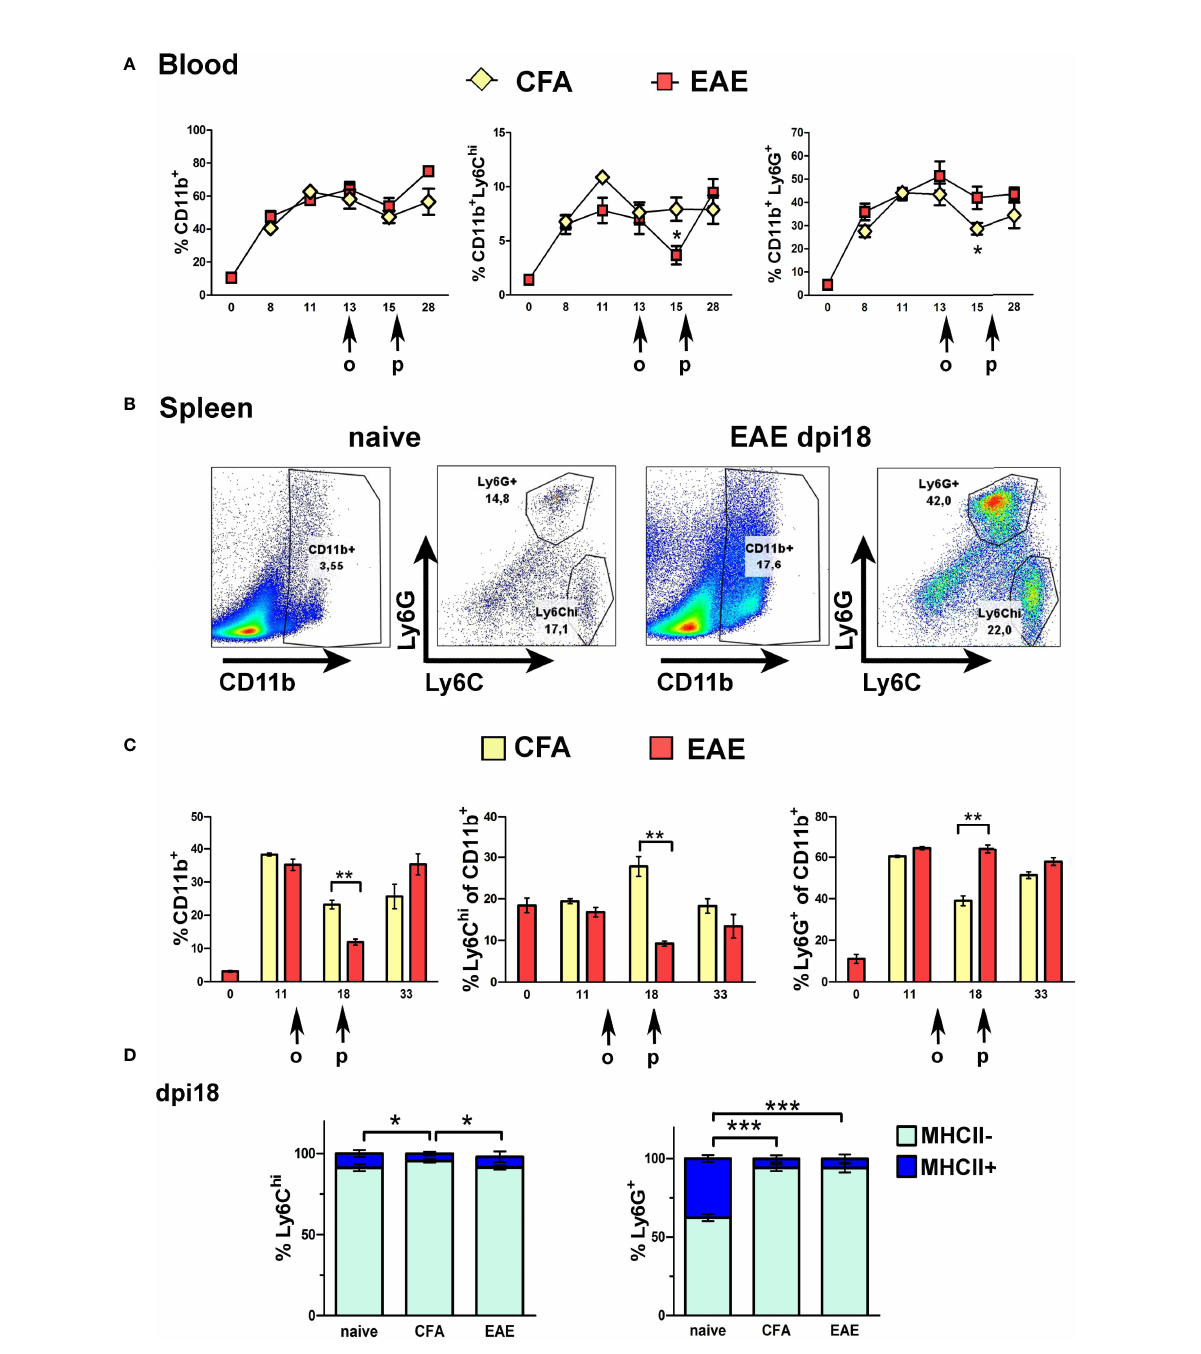
FIGURE 1 Ly6C hi and Ly6G + myeloid cells expand in the blood and spleen in response to immunization. (A) Time-course of CD11b + , Ly6C hi and Ly6G + myeloid cell expansion in blood of CFA and EAE immunized mice (n=2 at day 0 and n=4-5/group/time-point). Arrows indicate the days of onset (o) and peak (p) of clinical symptoms in the EAE mice. (B) Gating strategy of CD11b + sub-populations in spleens of naïve and EAE mice at the peak of clinical symptoms (dpi 18). (C) Time-course of CD11b + , Ly6C hi and Ly6G + myeloid cell expansion in spleens of CFA and EAE immunized mice (n=3-4/group/time-point). Arrows indicate the days of onset (o) and peak (p) of clinical symptoms in the EAE mice. (D) Proportions of MHCII - and MHCII + splenocytes within the Ly6C hi and Ly6G + subpopulations in CFA and EAE immunized mice at the peak of clinical symptoms (dpi 18) (n=3/group). Data and statistical analysis are derived from one experiment in each case (one for A , C , one for B , D ). Statistical signi fi cance is shown after pairwise comparisons between groups using Student ’ s t test (A, C) or multiple comparisons using one-way ANOVA followed by Tukey ’ s post hoc test (D) (*p ≤ 0.05, **p ≤ 0.01, ***p ≤